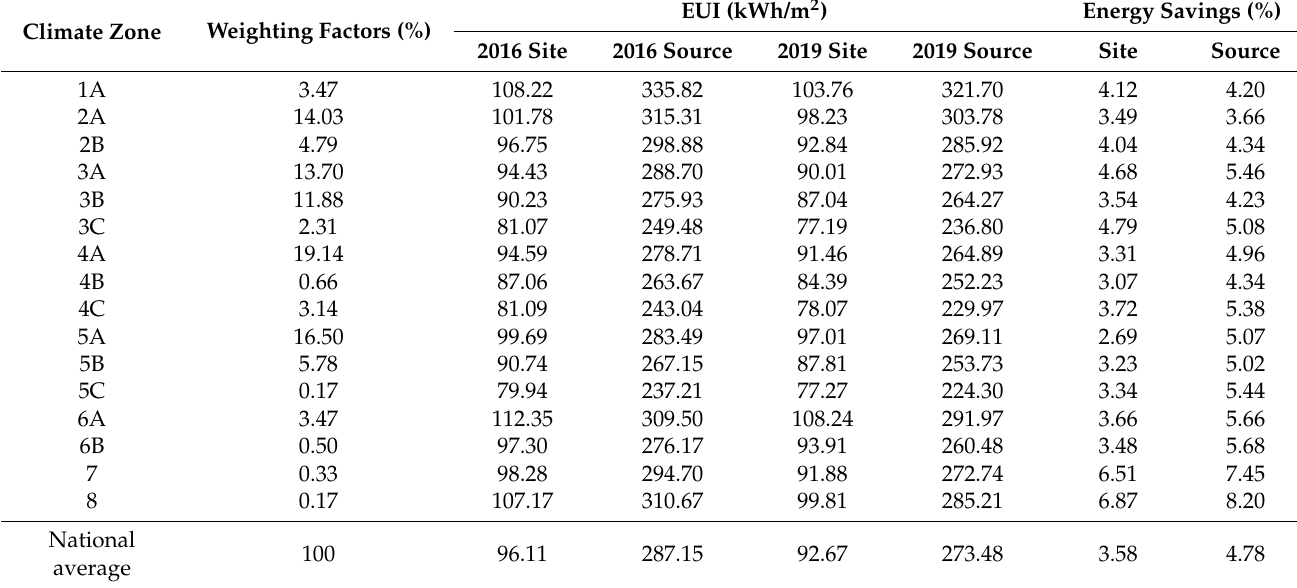
Table 7. The EUI and energy savings for the normal behavior